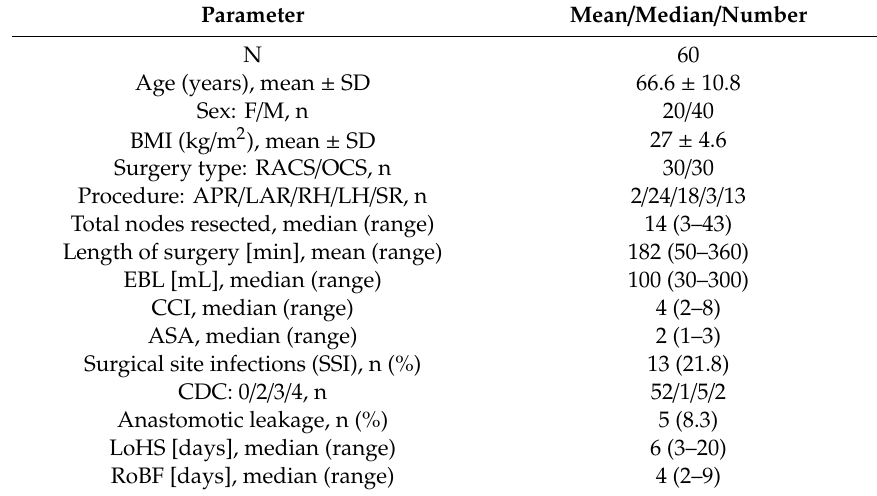
Table 2. Summary of patient- and surgery-related data for a follow-up cohort of colorectal cancer (CRC)